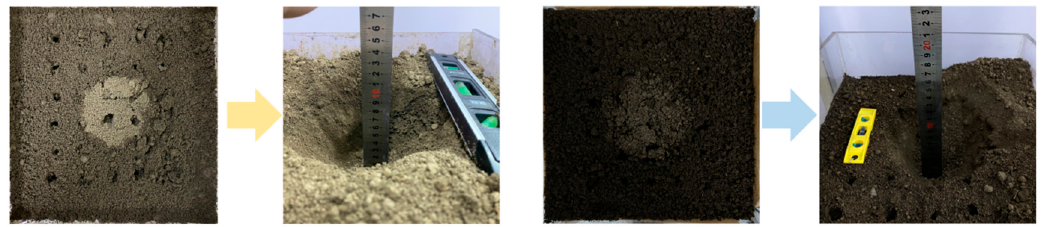
Figure 33. Soil surface and visible drying depth of 20% water-bearing loess and black soil after 12 min of microwave irradiation.